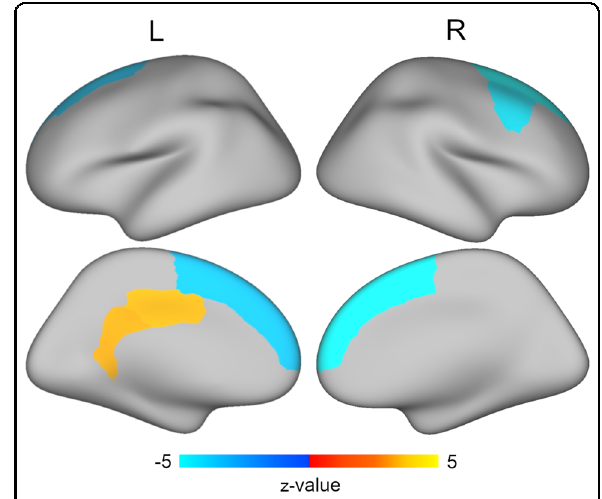
Fig. 3 Regions with signi fi cant associations between regional cortical thickness and latent trauma. Structural equation modeling that controlled for age, sex, race/ethnicity, scanner model, and average cortical thickness revealed that greater latent trauma scores were associated with thinner cortices in bilateral superior frontal gyri and right caudal middle frontal gyrus (blue) and thicker cortices in left isthmus cingulate and posterior cingulate (yellow). Multiple comparisons were accounted for using the false discovery rate ( q <